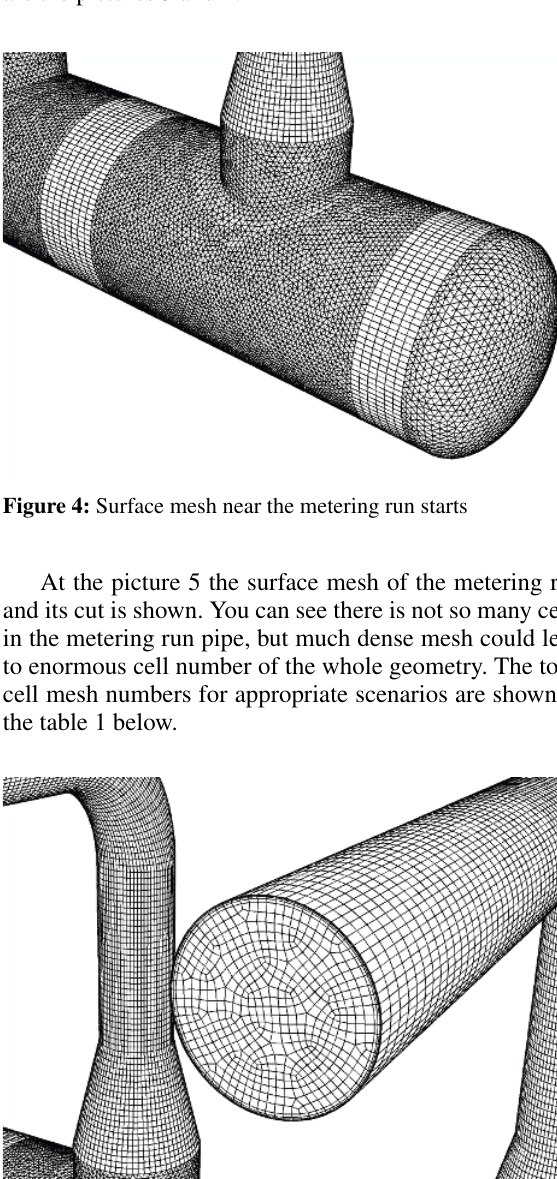
Boundary layers are used along all the surface to cover correctly the flow behavior in the near-wall region. Bound-